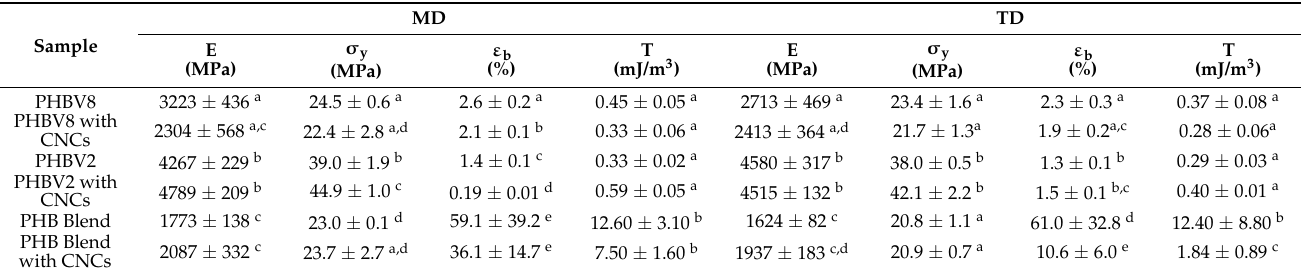
Table 2. Mechanical properties in terms of elastic modulus (E), tensile strength at yield ( σ y ), elongation at break ( ε b ), and toughness (T) of the different multilayers of poly(3-hydroxybutyrate- co -3-hydroxyvalerate) (PHBV) containing 8 mol.% (PHBV8) and 2 mol.% 3-hydroxyvalerate (PHBV2) and poly(3-hydroxybutyrate) with poly(butylene adipate- co - terephthalate) blend (PHB Blend) with and without cellulose nanocrystals (CNCs) in the transversal direction (TD) and machine direction